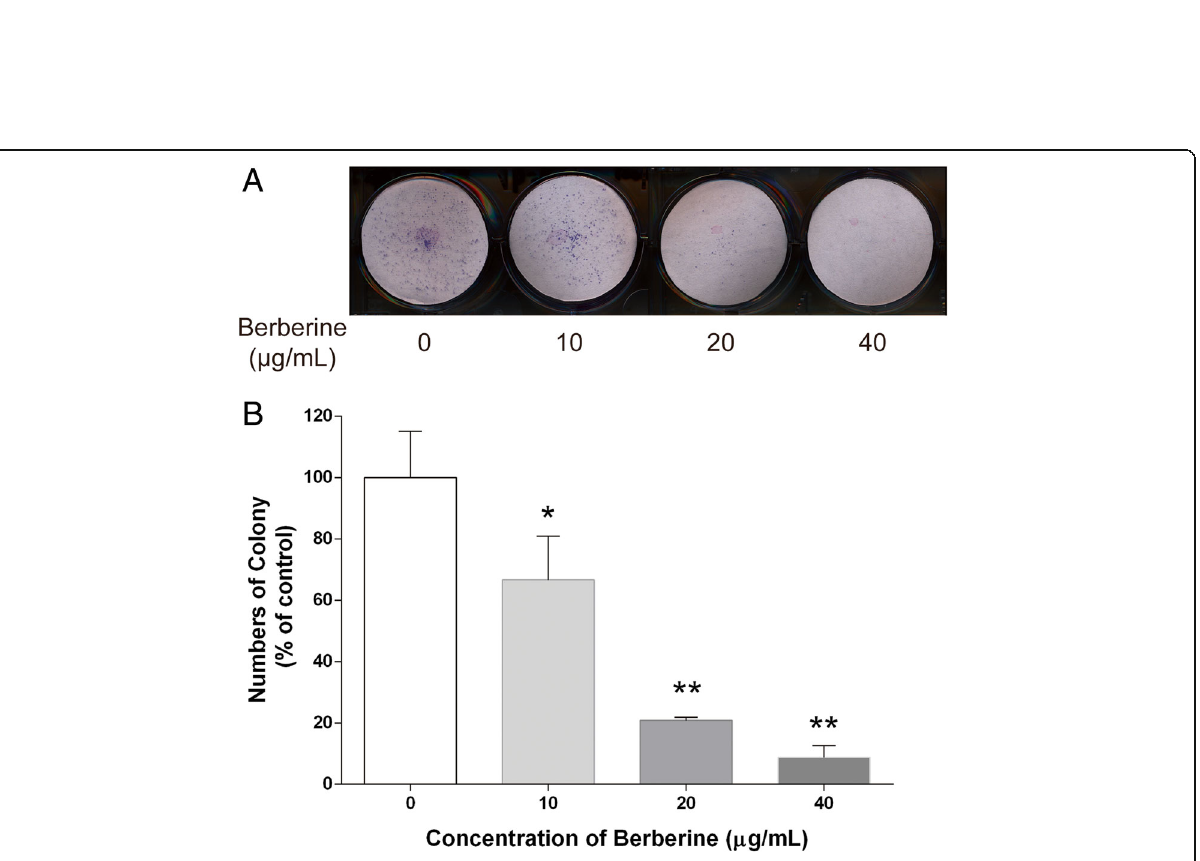
Fig. 2 Effect of BBR on colony formation potential of MDA-MB-231 cells. Cells were seeded in 6-well plates at 1000 cells per well following treatment with indicated concentrations of BBR for 24 h. The medium was then replaced with fresh media, and the cells were allowed to grow for 12 days at 37 °C in a humidified atmosphere (5% CO 2 in air) before staining with Giemsa stain solution. a Typical results of the clonogenic assay. b The surviving fraction of treated MDA-MB-231 cell line is presented as mean ± S.D. ( n = 3) of three independent experiments. * p < 0.05, ** p < 0.01, compared to the